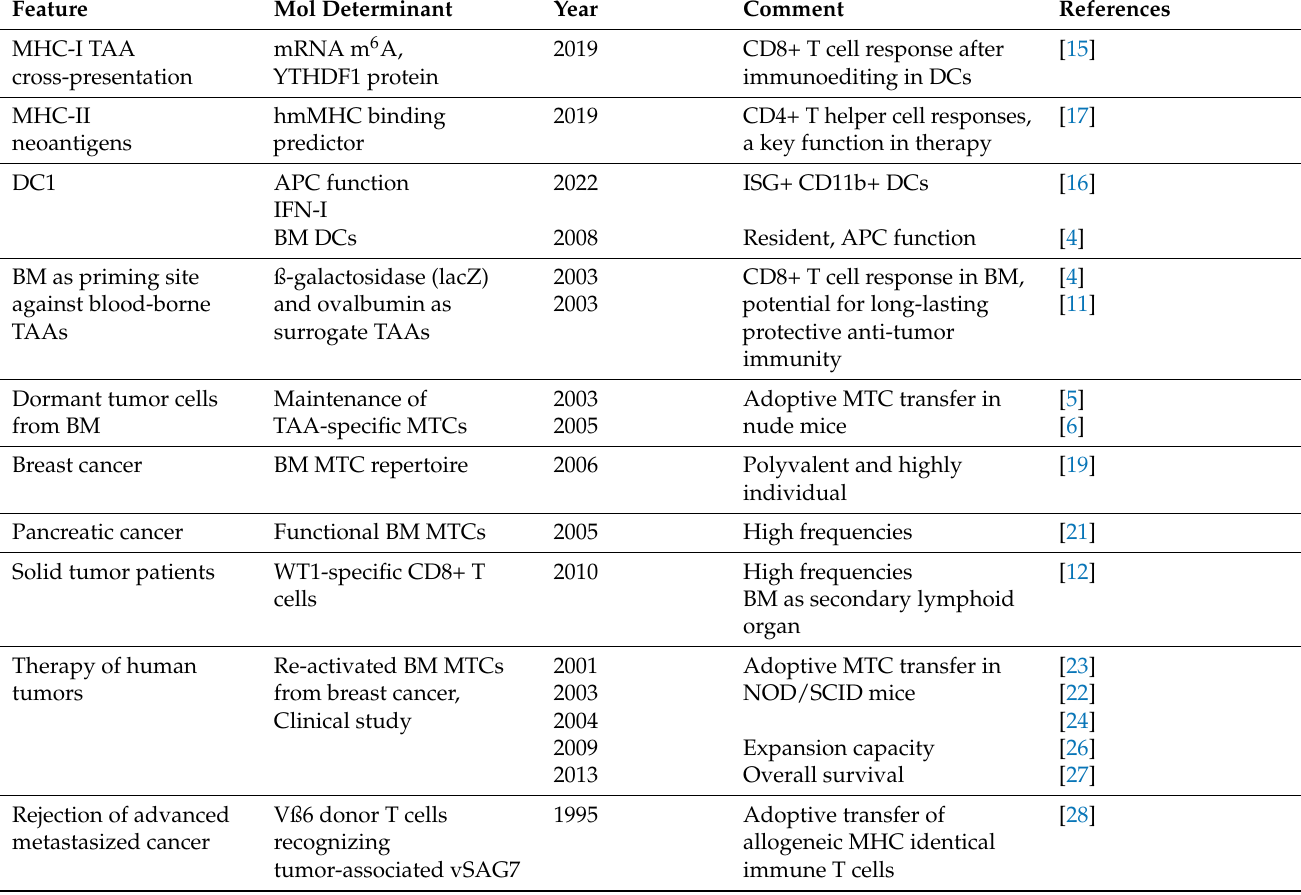
Table 1. Spontaneous anti-tumor T cell